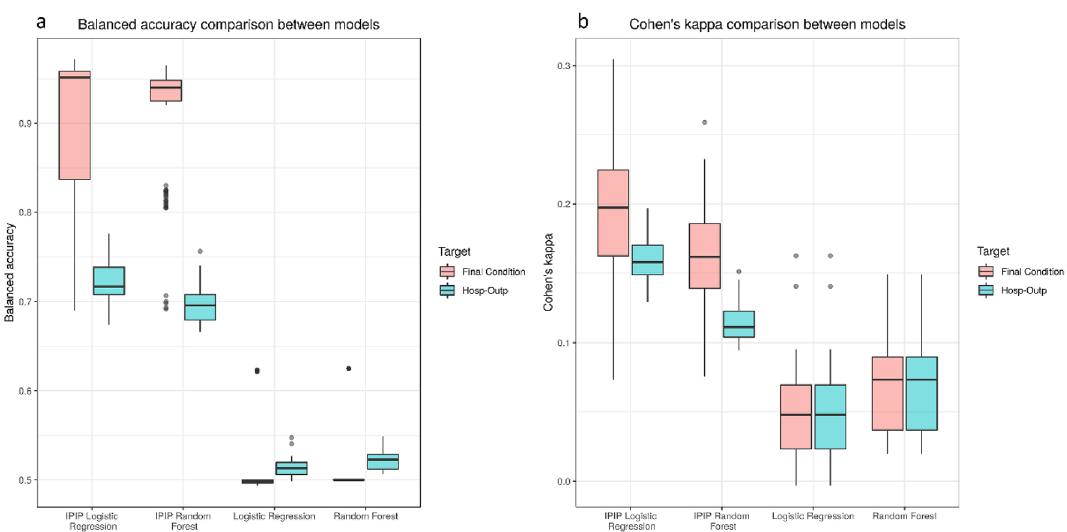
Figure 3. Accuracy and Cohen’s kappa resulting from the different models. ( a ) Accuracy boxplots obtained in the test of the models trained for each problem. ( b ) Cohen’s Kappa coefficients boxplots obtained in the test of the models trained for each